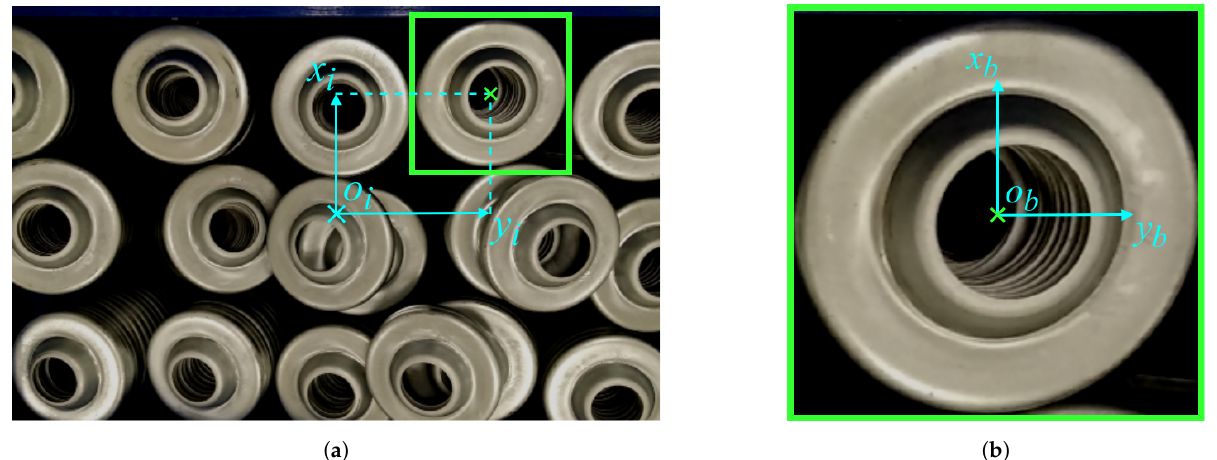
Figure 11. Translation prediction in the xy plane. ( a ) Image coordinates. ( b ) Bounding box